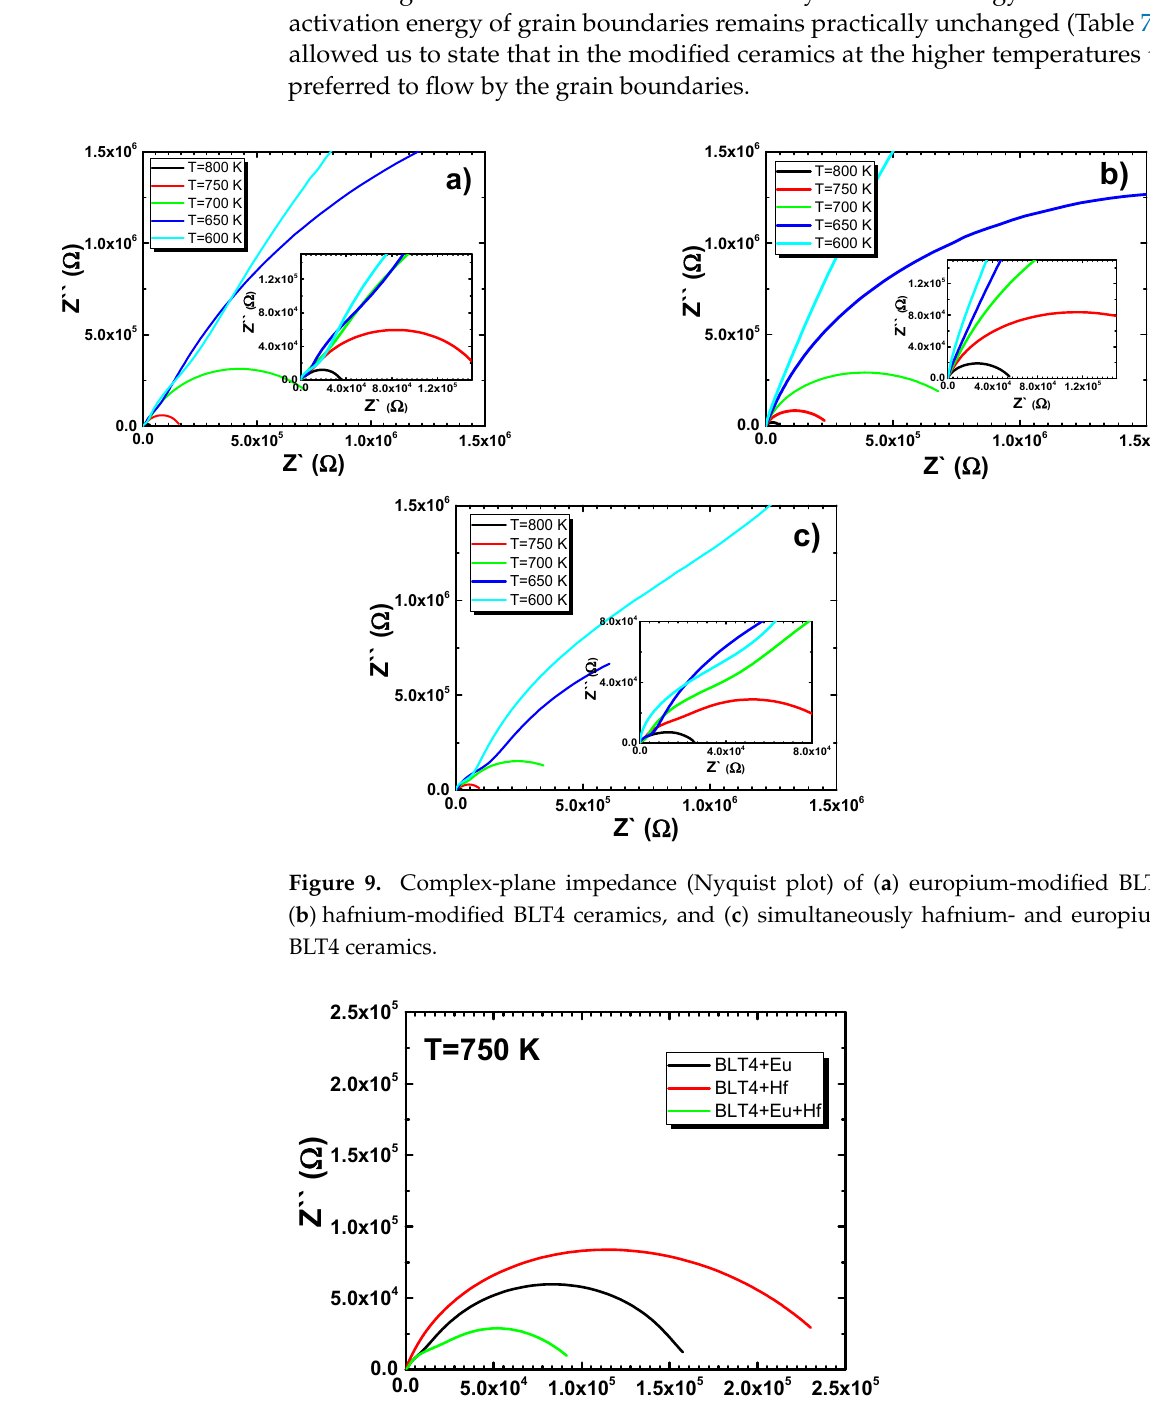
Figure 8. Frequency dependence of the imaginary part of impedance measured at different temper- atures for ( a ) europium-modified BLT4 ceramics, ( b ) hafnium-modified BLT4 ceramics, and ( c ) sim- ultaneously hafnium- and europium-modified BLT4 ceramics.